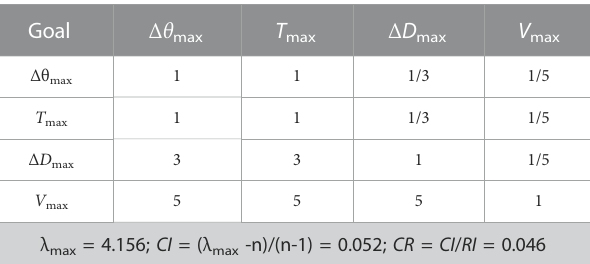
weight results. The results showed that the CI value of the primary indicators was 0.052 and that the CR value was 0.046, i.e., both < 0.1, indicating that the degree of consistency was good. Table 5 presents the comparative judgment matrix of the secondary indicators corresponding to all the primary indicators, and using the comparative judgement matrix corresponding to each indicator, the weight values and eigenvector values corresponding to each indicator were further calculated and their results tested for consistency. The results showed that the CI and CR values of the secondary indicators corresponding to the four primary indicators were < 0.1, indicating good agreement. After obtaining the weight values of all the primary and secondary indicators, the fi nal weight values of the indicators were calculated, as shown in Table 6.